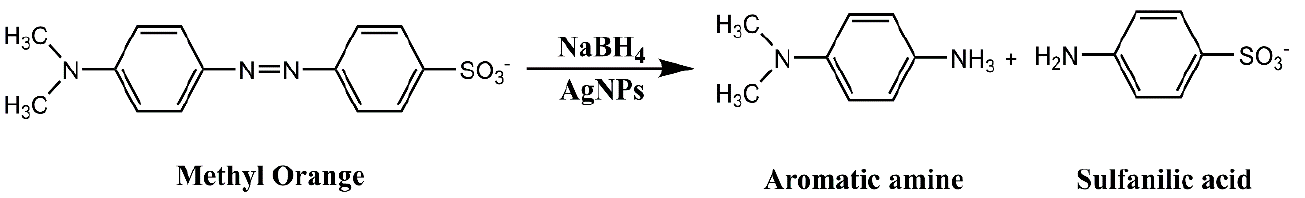
Figure 9 . Bar graph of MB degradation at different time intervals . Figure 9. Bar graph of MB degradation at different time intervals.